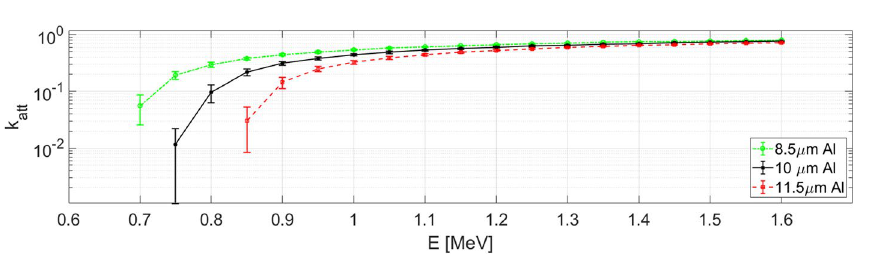
Figure 2. ( a ) The acquisition system configuration for the CVD diamond detectors and ( b ) a typical TOF signal acquired with the described system on channel 1 (Ch1) and channel 3 (Ch3) of the oscilloscope ( c ) proton spectrum obtained for the Shot #38 with the described procedure. The vertical yellow line indicates the maximum proton energy ( E pM ) and the magenta line corresponds to the energy where the ion contribution to (cid:31) E pM ). the spectrum ends ( E pM −